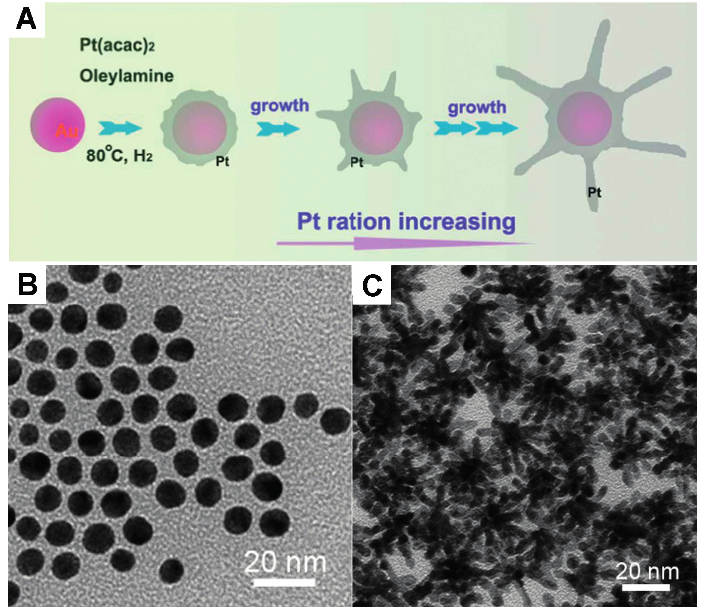
Figure 5. ( A ) The synthetic scheme of Au-Pt bimetallic nanocomplexes; ( B ) The TEM image of Au nanoparticles; ( C ) The TEM image of Au-Pt bimetallic nanocomplexes